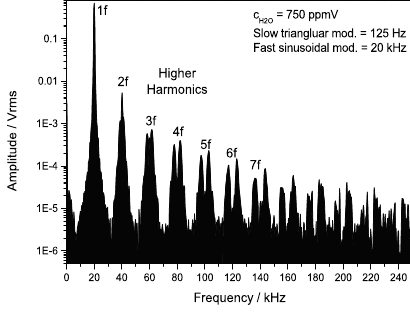
Figure 3. Experimental frequency spectrum of the digitized, high-pass filtered photodiode raw signal measured for 750 ppmV H 2 O. For WMS a 125 Hz linear triangular modulation is used to scan over the absorption line. This scan is superimposed with a 20 kHz sinusoidal